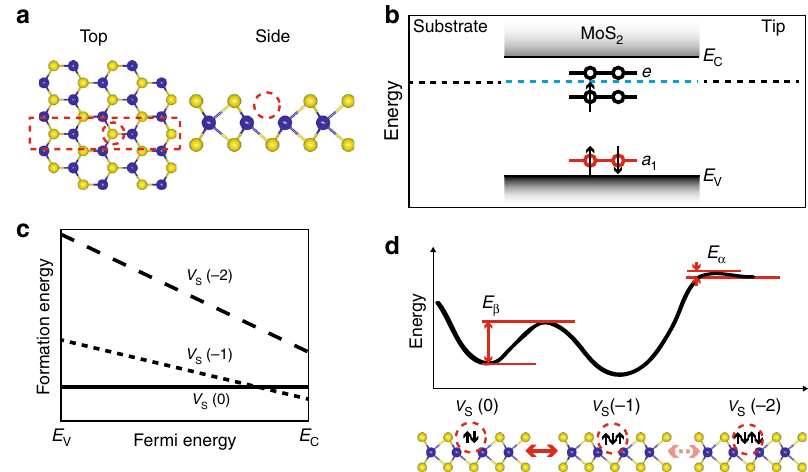
E fi xed by the work function of gold, at a F is